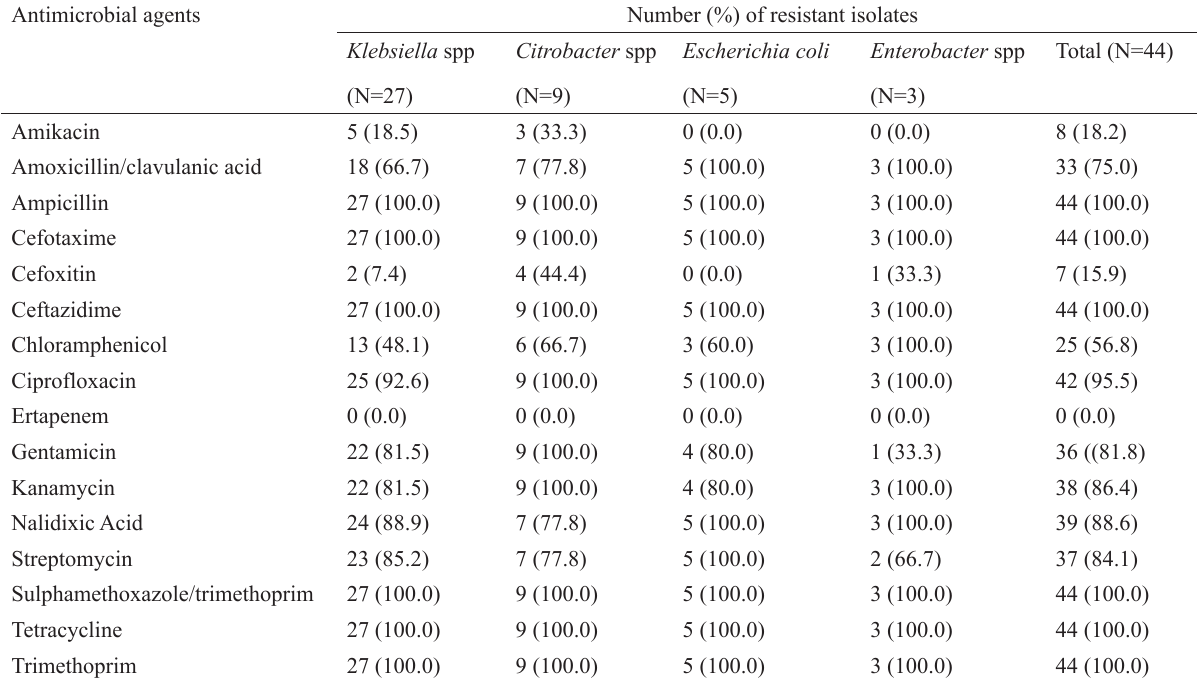
Table 3: Antimicrobial rates of ESBL-producing Enterobacteriaceae from public toilets in Abeokuta, Nigeria. Antimicrobial agents Number (%) of resistant isolates